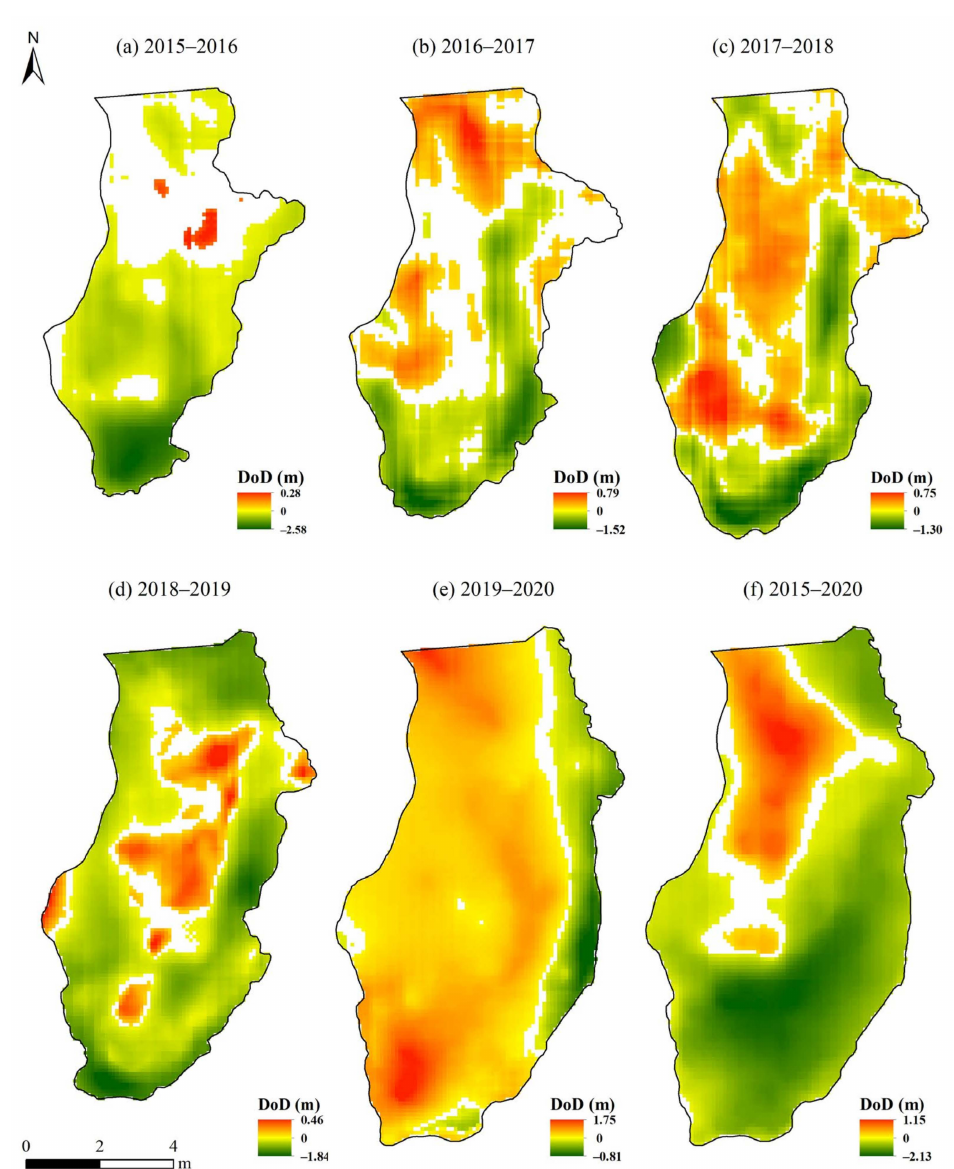
Figure 11. DoD map of the headcut in